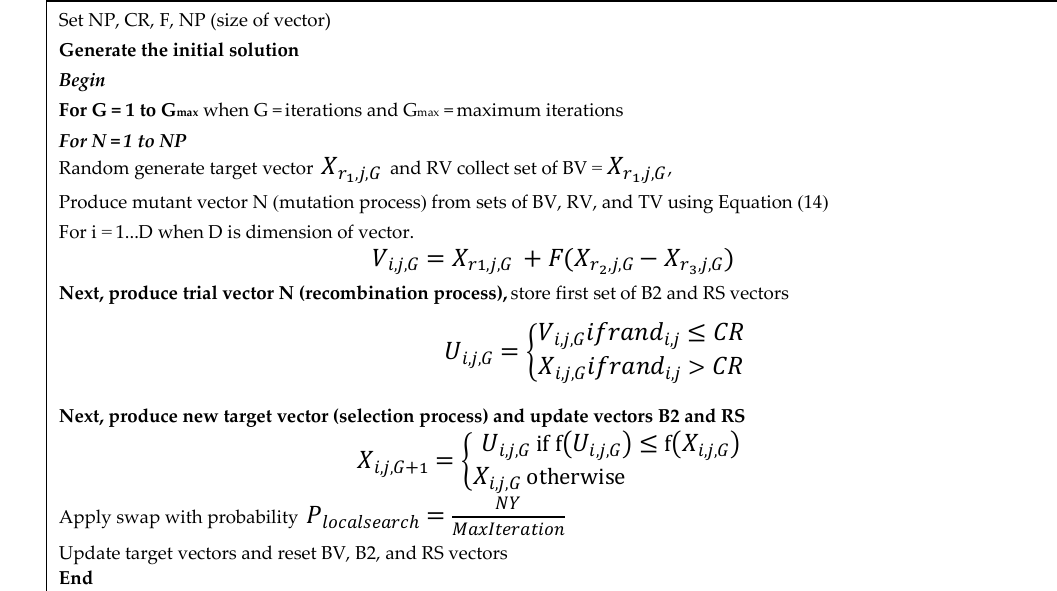
Figure 4. Pseudo-code of modified DE.